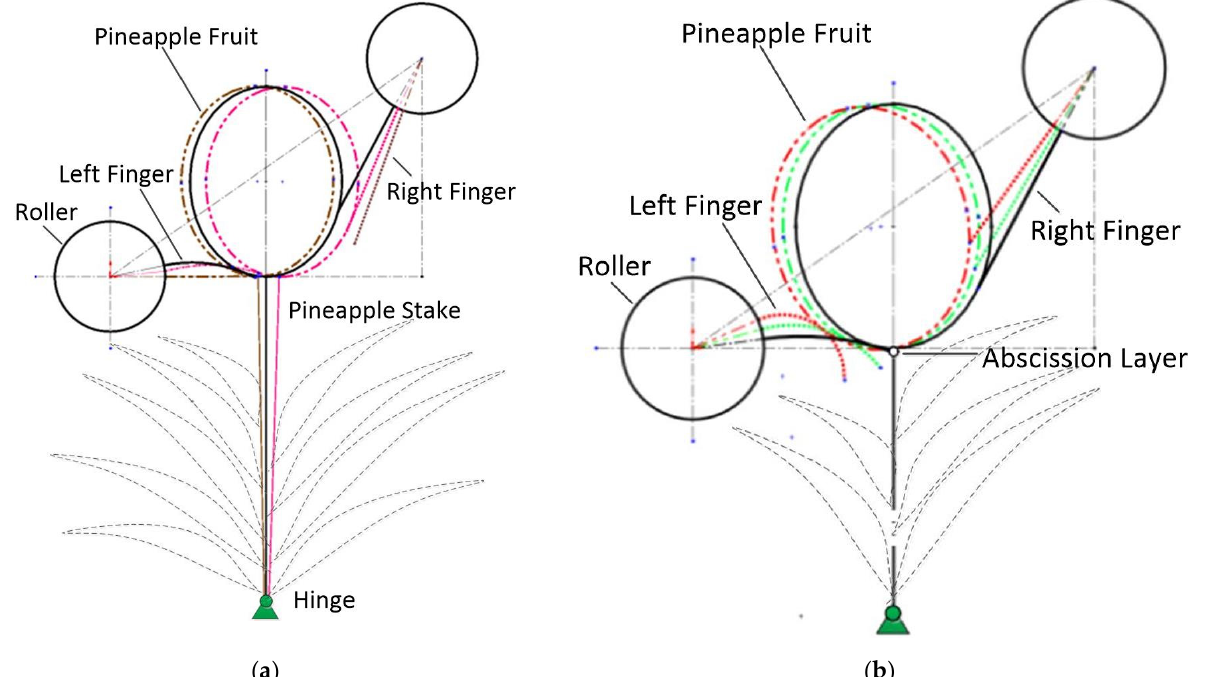
Figure 12. Schematic diagram of the interaction of flexible fingers with pineapple. ( a ) Before the right finger contact. ( b ) After the right finger contact.